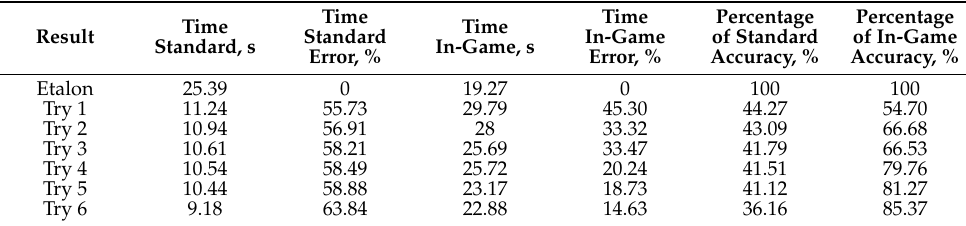
Table 8. Players time